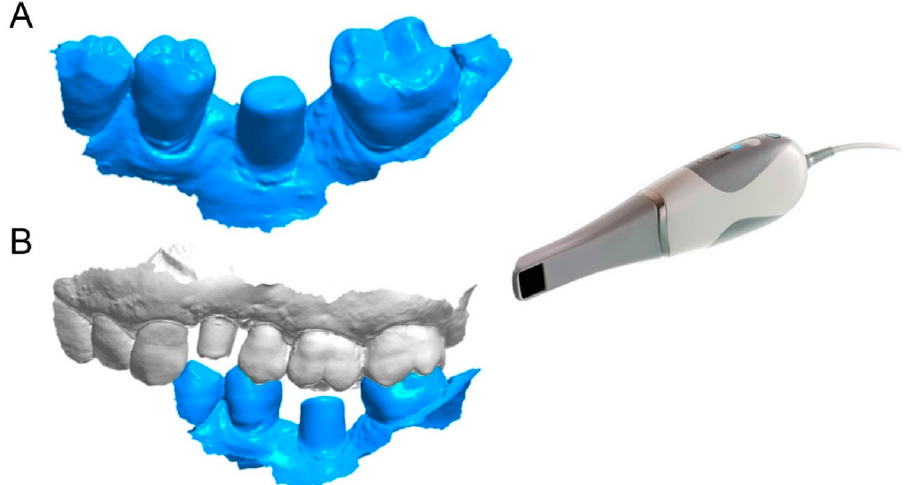
Figure 6. After 2 months of provisionalization, the patient is ready for the final scan. ( A ) the provisional PMMA crown in situ after a 2 ‐ month period; ( B ) The zirconia abutment immediately after the removal of the PMMA crown.